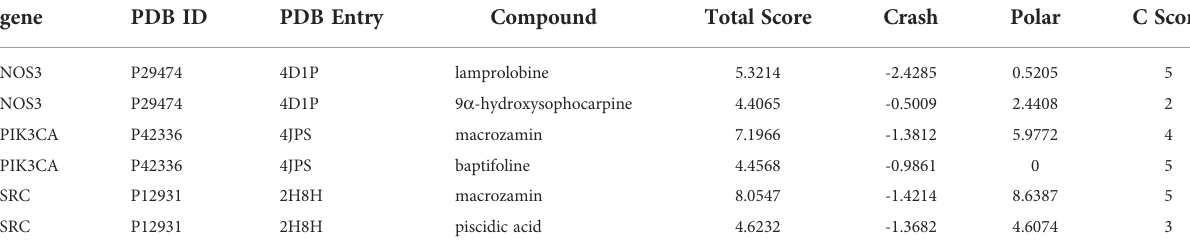
TABLE 3 Docking information of VEGF signaling pathway-related predicted target with active components of